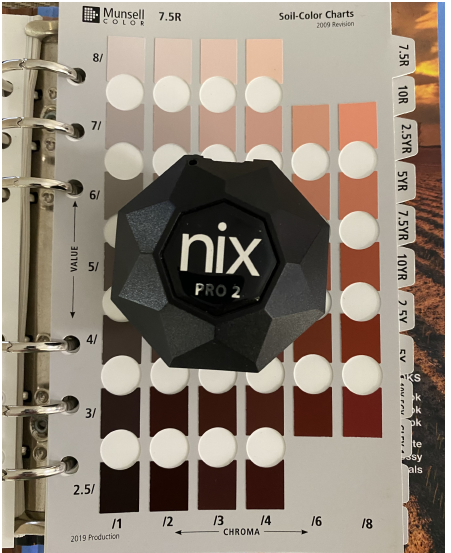
Figure 4. Data collection of ground-truth data using Nix